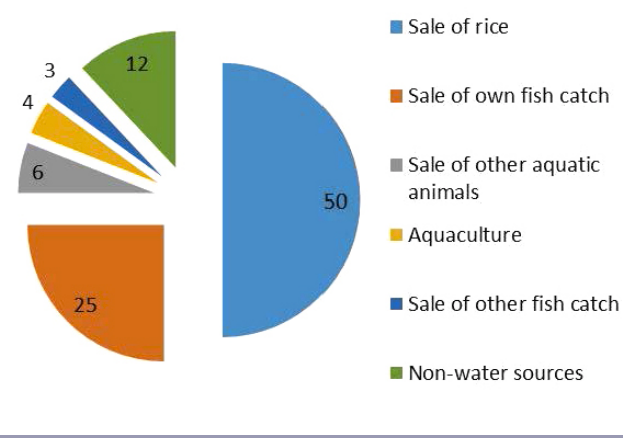
Fig. 2. Proportional income sources of rural residents in the lower Meking basin corridor. The Mekong corridor encompasses 15 km on either side of the mainstream. Source data from MRC (2010 d